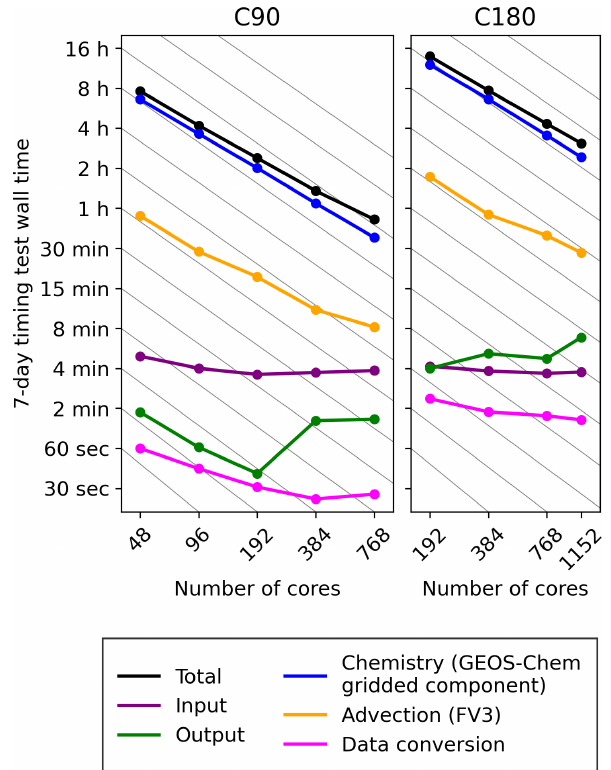
Figure 6. Component-wise breakdown of the total wall times for timing tests on the Cannon cluster. Grey lines indicate ideal